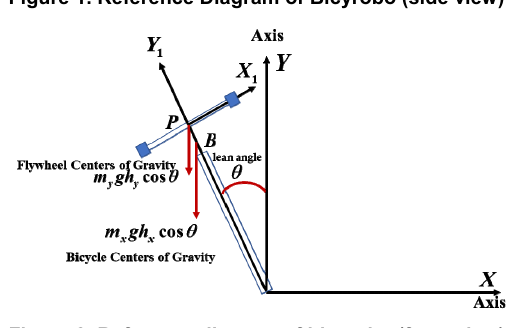
Figure 2. Reference diagram of bicyrobo (front